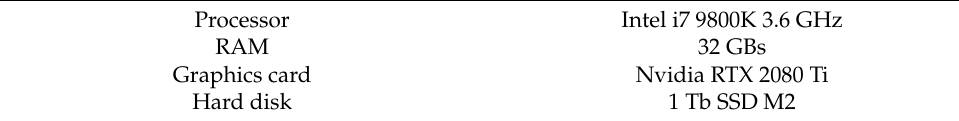
Table 2. Hardware used for training.